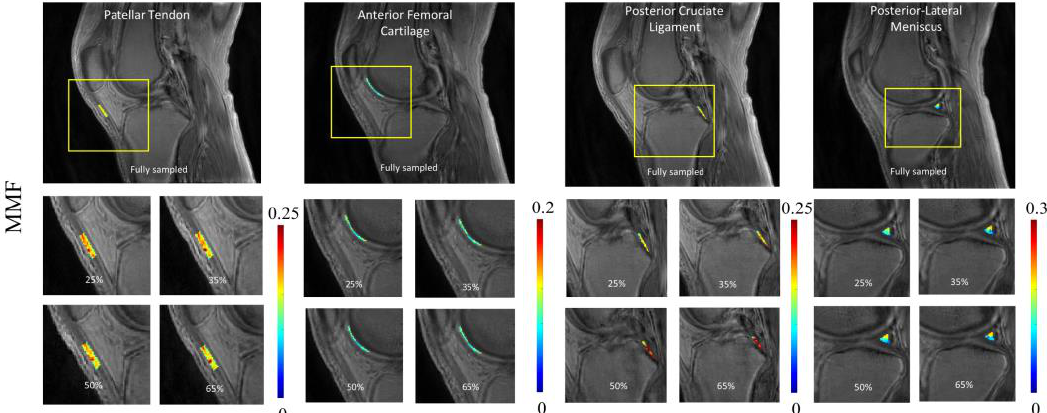
Figure 7. Quantitative mapping of UTE-qMT parameter (i.e., MMF) at different undersampling levels in four representative ROIs. The estimated MMF ranged between 0.12 and 0.19. For the PCL region, due to partial volume effect, quantitative maps showed visible changes between images with different undersampling rates.